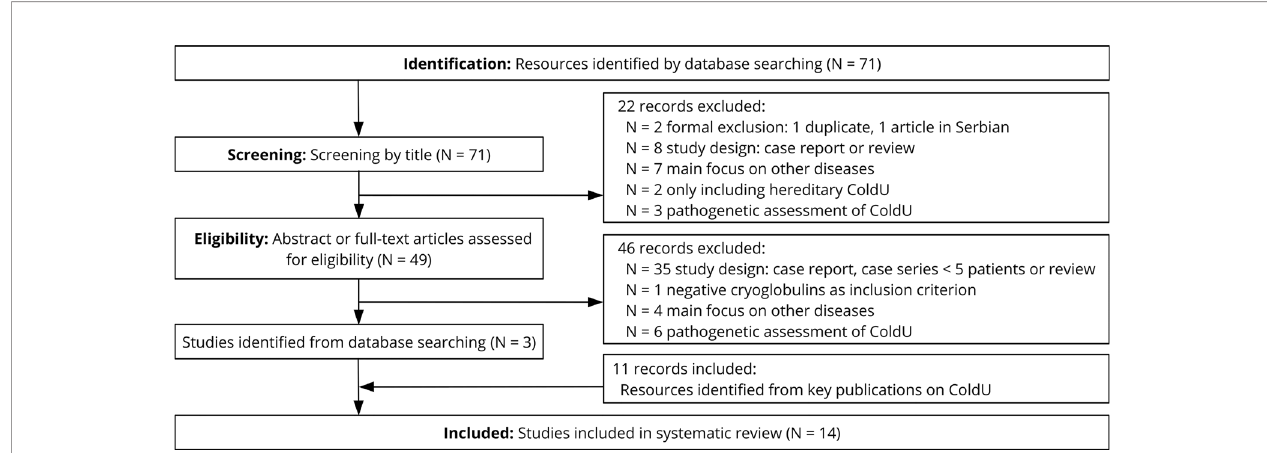
FIGURE 1 | Study selection process during the systematic literature